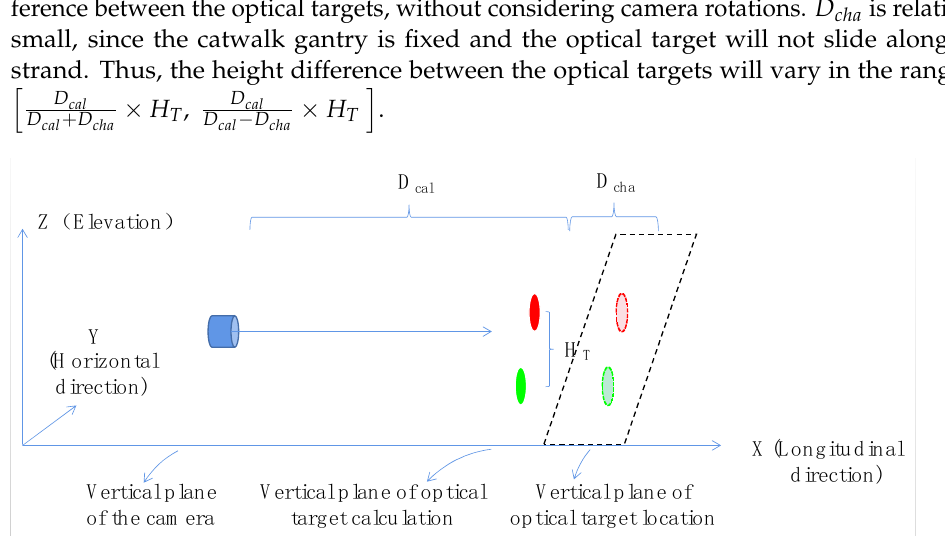
Figure 10. Schematic diagram of the spatial relationship between the camera and the optical target. Under wind actions, the camera rotates in the longitudinal direction, causing the image deflection does not change the actual spatial distance (i.e., D cen ) between the target centers. Assuming that the angle between the line connecting the targets and the horizontal direction is β , when the rolling angle is 0 ◦ , the height difference between the optical targets can be expressed as H T = D cen × sin β . When the roll angle is α , the height difference is calculated as H rot = D cen × sin ( β + α ) .